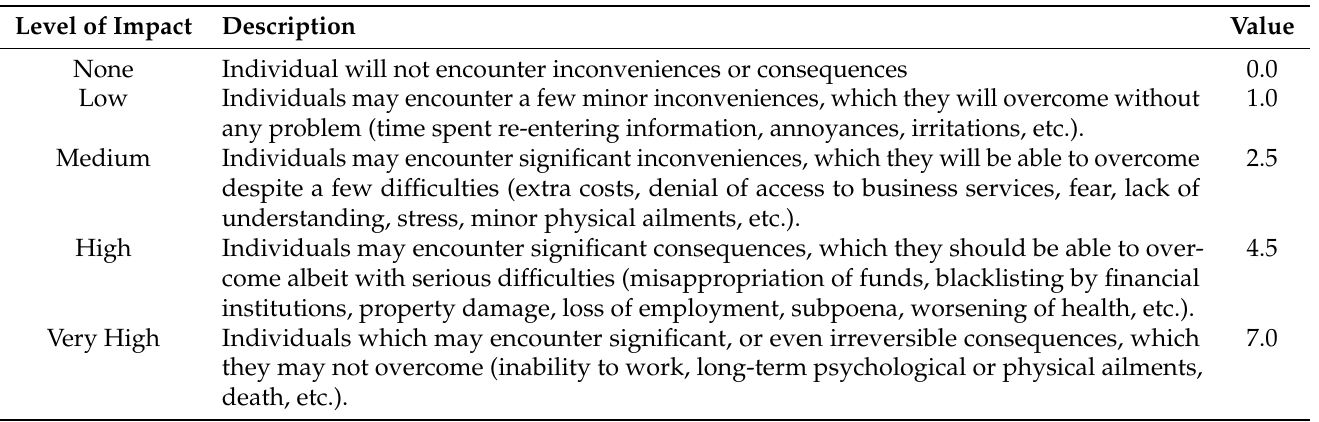
Table 2. Impact categories on the fundamental rights and freedoms of the individuals, resulting from the possible loss of security of the personal data according to ENISA (European Union Agency for